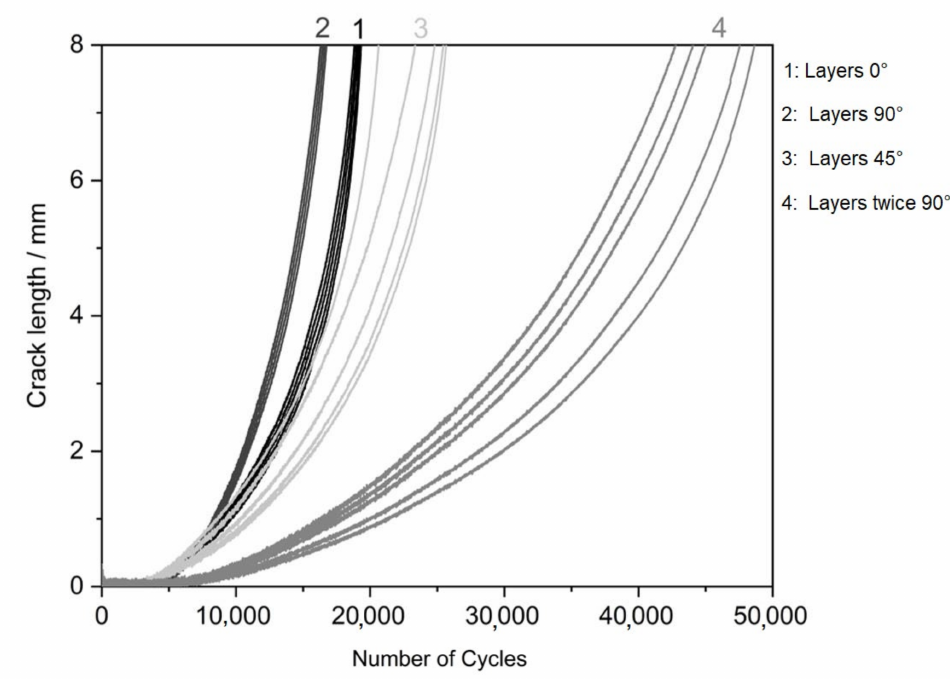
Figure 6. The number of loading cycles for all topology